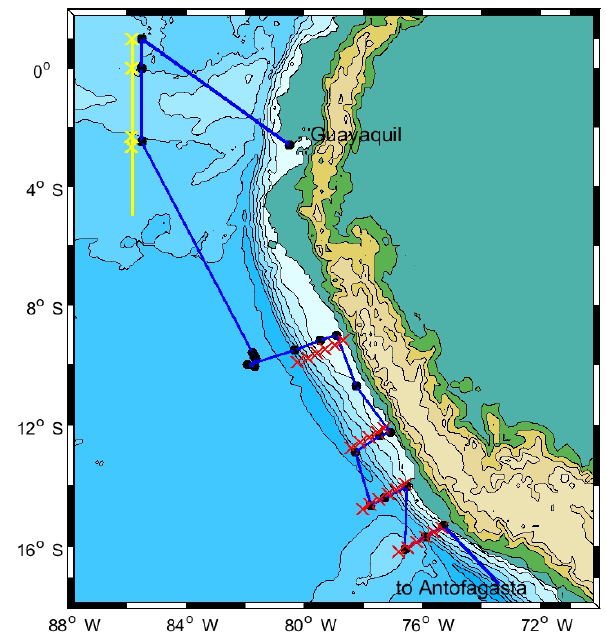
Figure 1. Cruise track (blue line) and CTD (conductivity– temperature–depth) stations (black circles) of cruise R/V Sonne from Guayaquil 5 October to Antofagasta 22 October 2015, as well as equatorial stations March 1993, February 2009, and Novem- ber 2012 (yellow “x”), CTD sections off Peru December 2012 (red “x”), and ADCP sections across the Equator (yellow line). Topog- raphy (color) with depth/height contours in 1000m intervals en- hanced by the 200m depth